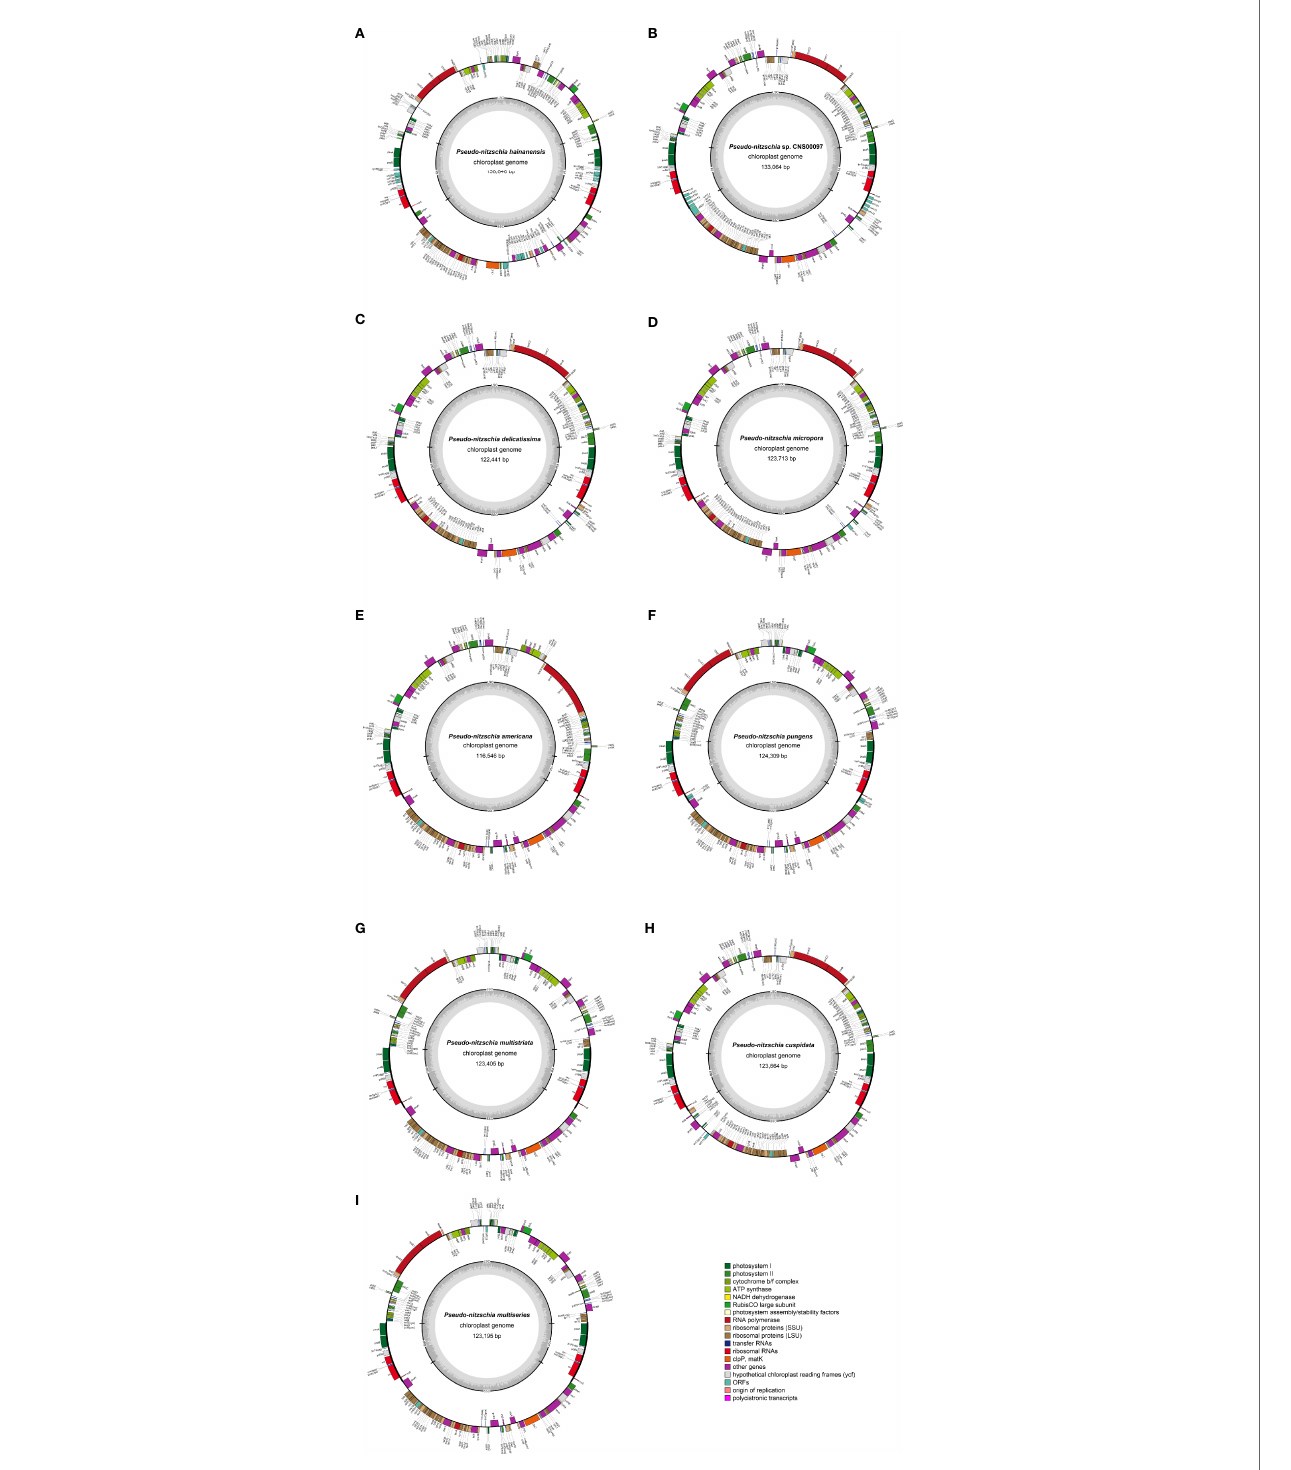
FIGURE 2 | Gene maps of cpDNAs of P. hainanensis CNS00090 (A) , Pseudo-nitzschia sp. CNS00097 (B) , P. delicatissima CNS00130 (C) , P. micropora CNS00133 (D) , P. americana CNS00138 (E) , P. pungens CNS00141 (F) , P. multistriata CN00142 (G) , P. cuspidata CNS00150 (H) , and P. multiseries CNS00159 (I) . The genes drawn outside and inside of the circle are transcribed in clockwise and counterclockwise directions, respectively. Genes were colored based on their functional groups. The inner circle shows the quadripartite structure of the chloroplast: small single copy (SSC), large single copy (LSC) and a pair of inverted repeats (IRa and IRb). The gray ring marks the GC content with the inner circle marking a 50%